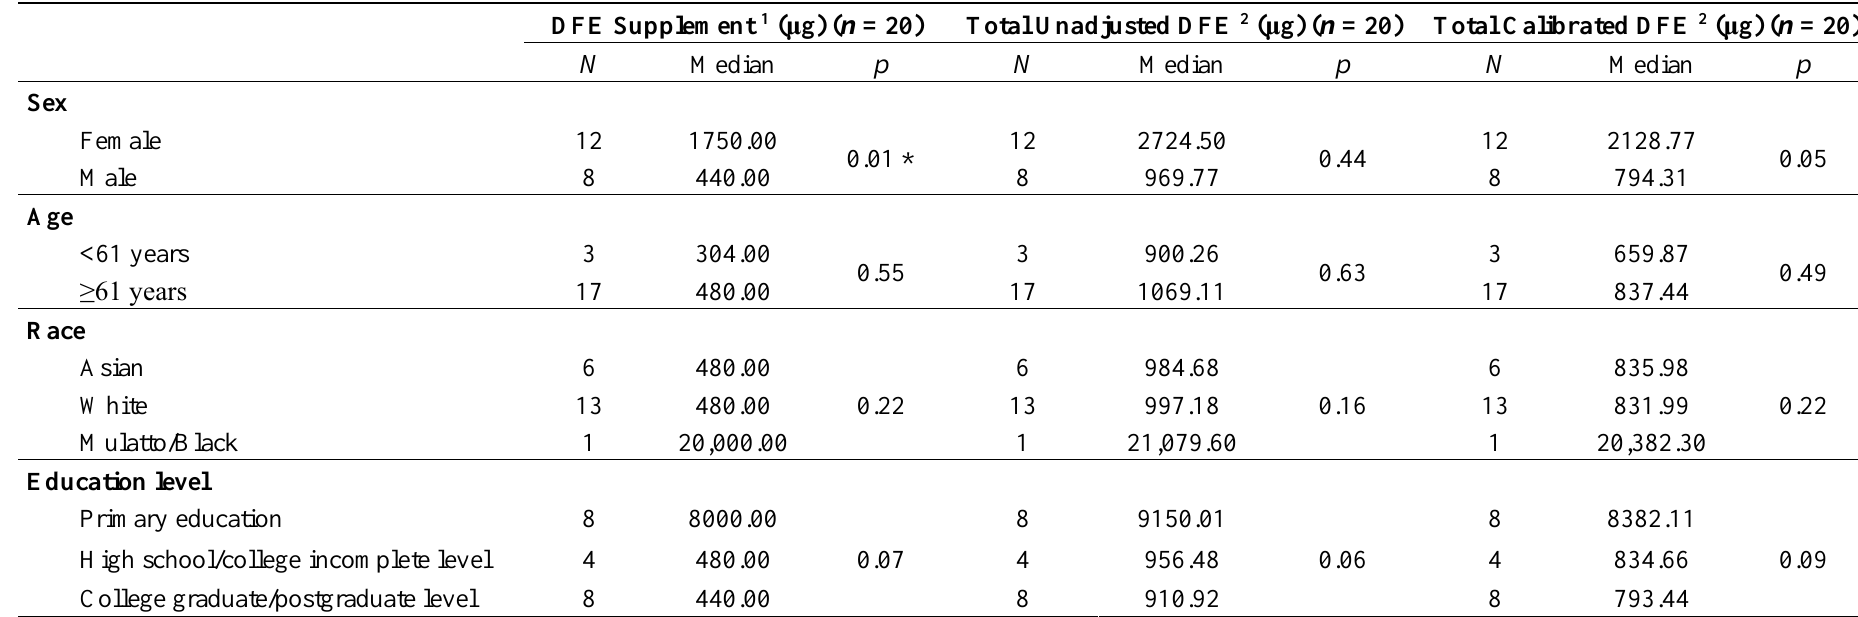
Table 4. Comparison of the medians of supplement, total unadjusted and total calibrated DFE according to sociodemographic characteristics in the pretreatment of patients for colorectal